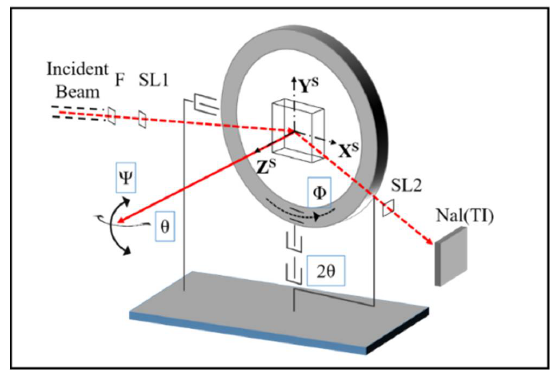
Figure 2. The schematic of the pole figure attachment geometry.